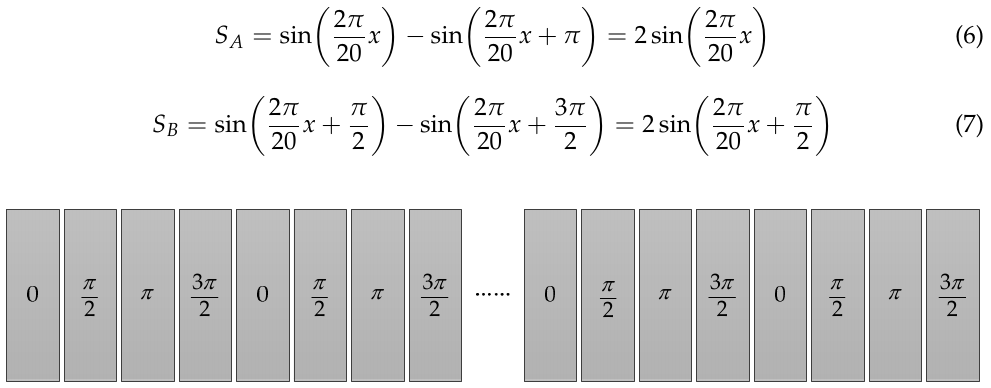
Figure 3. Phase arrangement of longitudinal Moiré fringe signals received by photoelectric device.